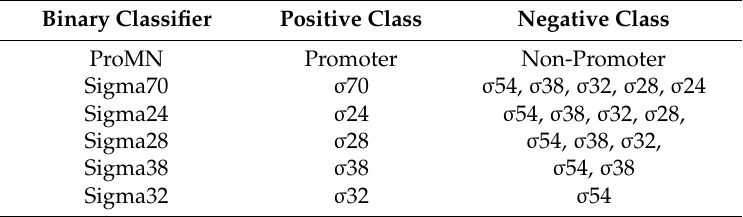
Figure3showstheproposedCNNarchitecturefortheclassificationofpromotersandnon-promoters.